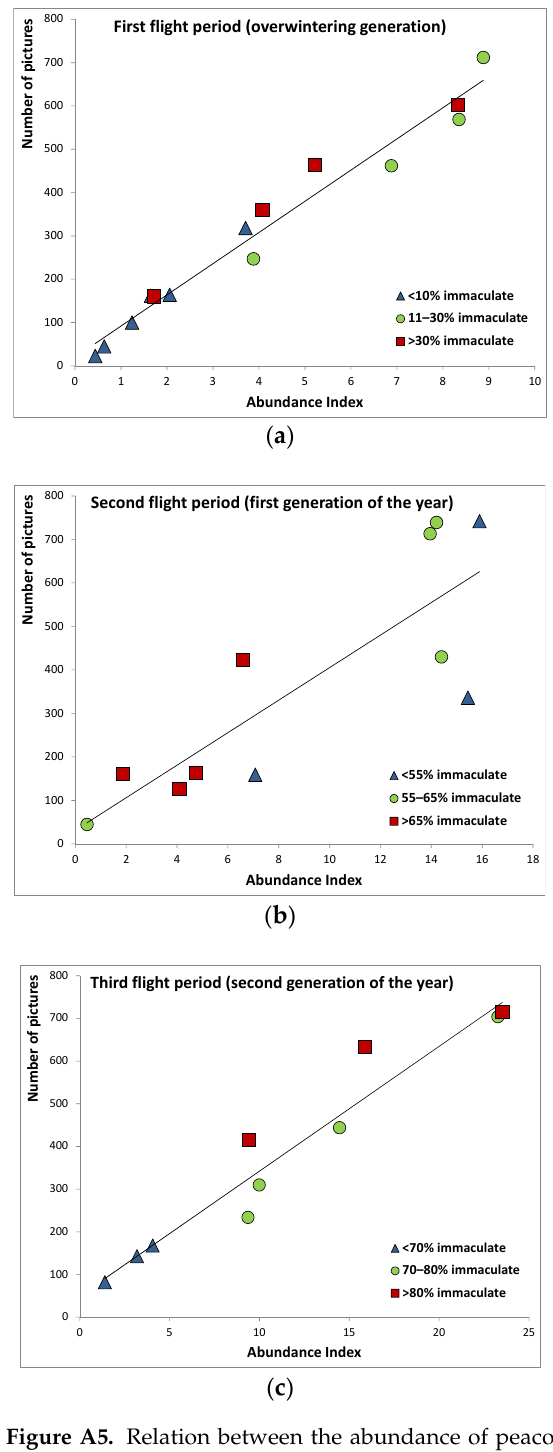
Figure A5. Relation between the abundance of peacock butterflies in Belgium by week and the number of pictures submitted in that week differentiated for the average state of wear of butterflies in that week for the first ( a ), second ( b ), and third ( c ) flight peak.